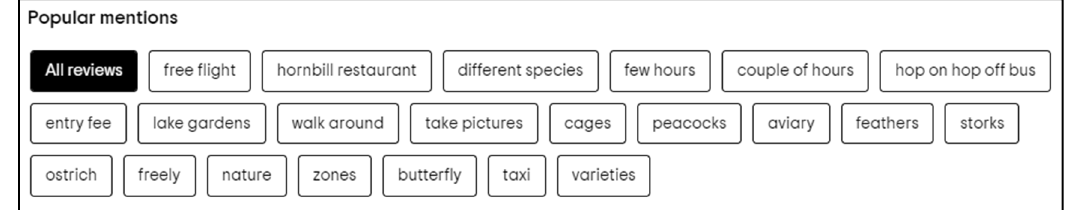
Figure 9. TripAdvisor reviews’ tags for KL Bird Park.